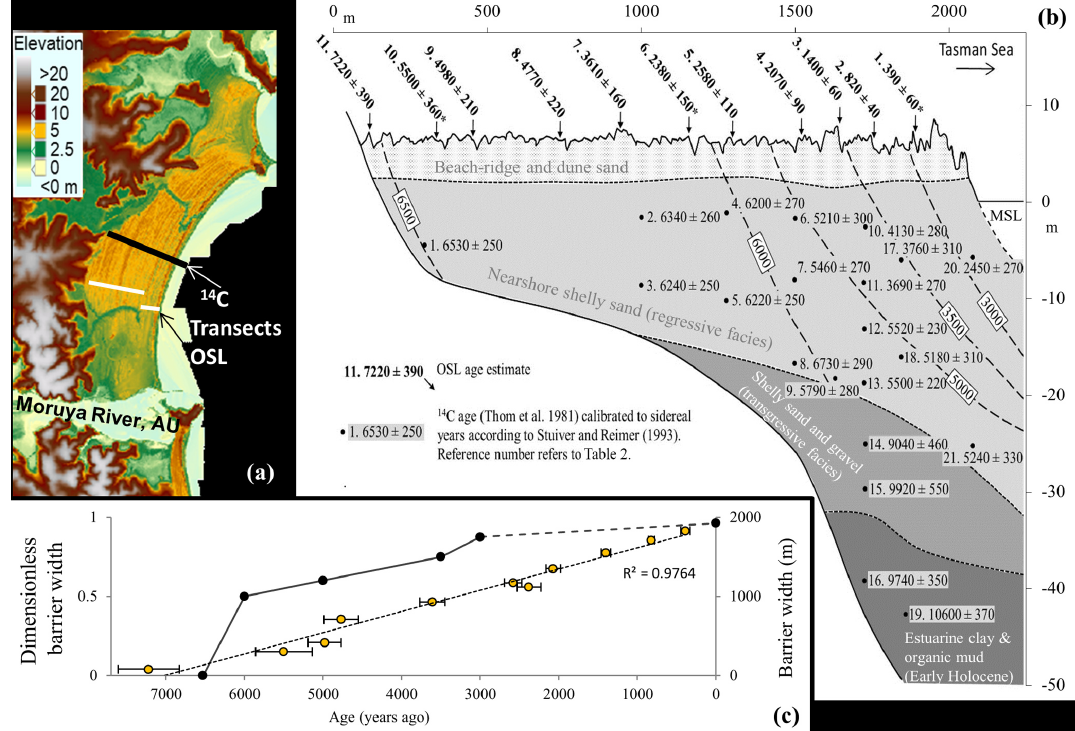
Figure 1. (a) Lidar data of the prograded barrier system near Moruya, Australia, with the location of the transects where 14 C and OSL samples were collected. (b) Stratigraphic cross section of Moruya Barrier displaying radiocarbon (calyrBP) and OSL (years before 2012– 2013) chronologies (Oliver et al., 2015; Thom et al., 1981). (c) Diagram of barrier width as a function of OSL (yellow dots with black circles) and radiocarbon (black dots) ages. The new OSL chronology shows that progradation has been much more linear than was previously thought using radiocarbon. Figure modified from Dougherty et al. (2016) and Oliver et al.